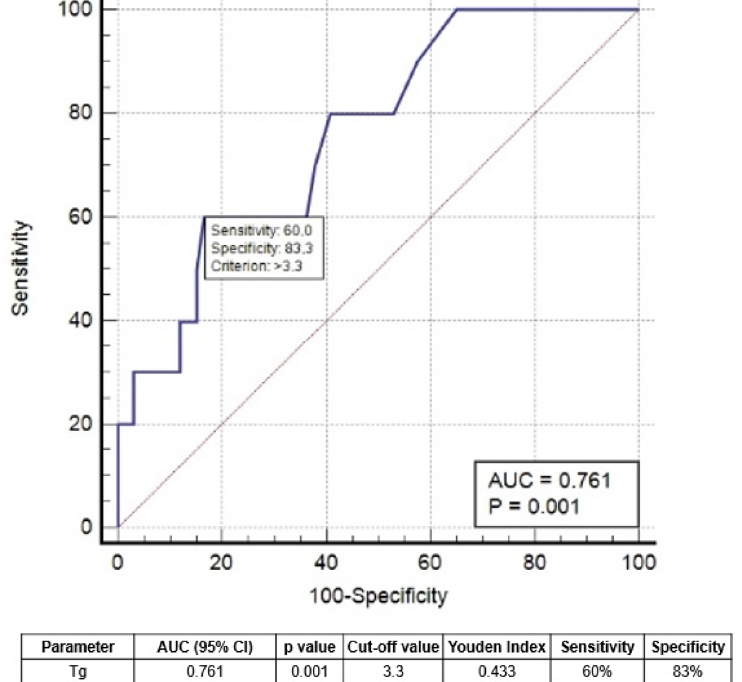
Figure 3. ROC curve analysis to determine the best threshold of sTg to predict progression/relapse. Four patients with sTg < 3.3 ng/mL developed relapse/progression, while 5 had sTg > 3.3 ng/mL ( p < 0.002). PFS in patients with sTg < 3.3 ng/mL was not significantly different from IRTgAb+ and IRImaging+ patients (Figure 4).